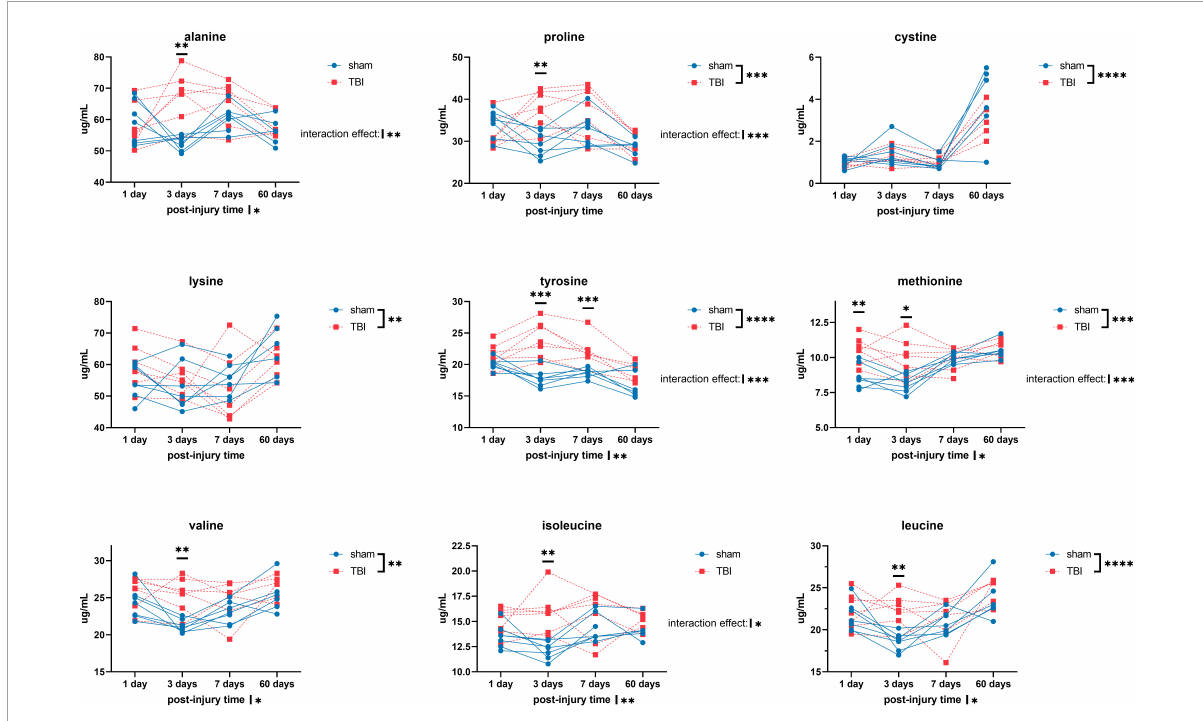
FIGURE2 Plasma levels of amino acids: alanine, proline, cystine, lysine, tyrosine, methionine, valine, isoleucine, and leucine of sham and TBI animals at day one, three, seven, and sixty post-procedure. Asterisks ( ∗ ) next to sham/TBI legends, post-injury time axis label, and interaction effect indicated statistically significant group, post-injury time, and group × post-injury time effects, respectively, in ANOVA. ∗ On the graph at each timepoint indicated significant difference between TBI and sham animals at each timepoint, Fisher’s Least Squared Difference post-hoc test.